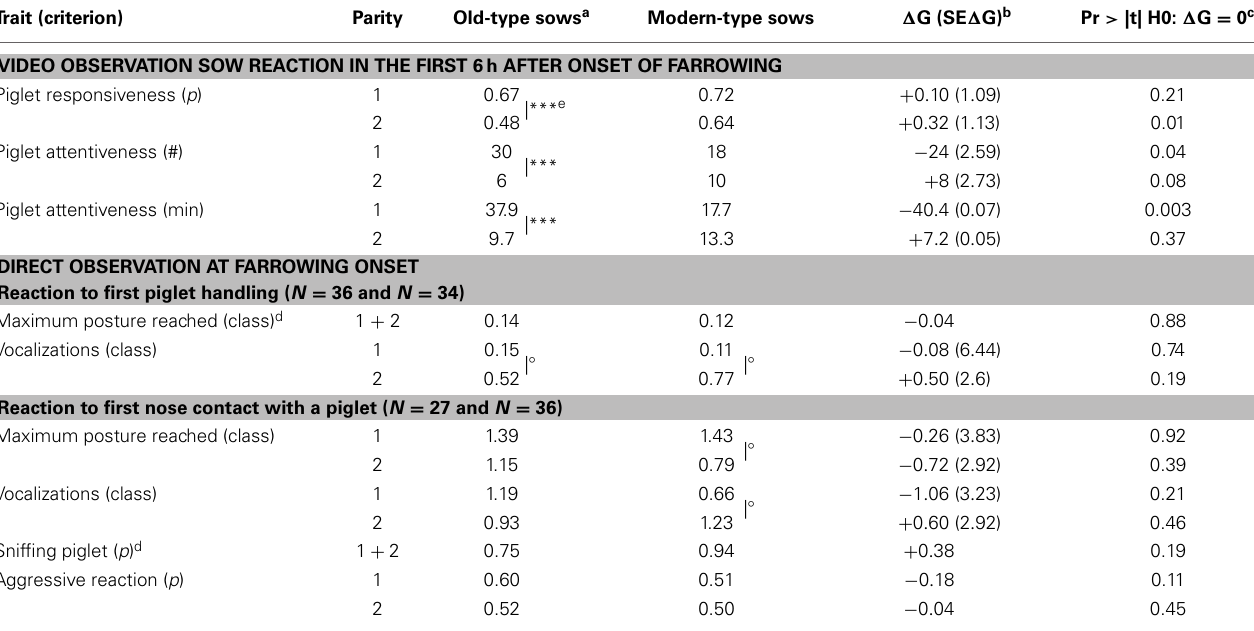
Table 5 | Genetic trends for sow maternal